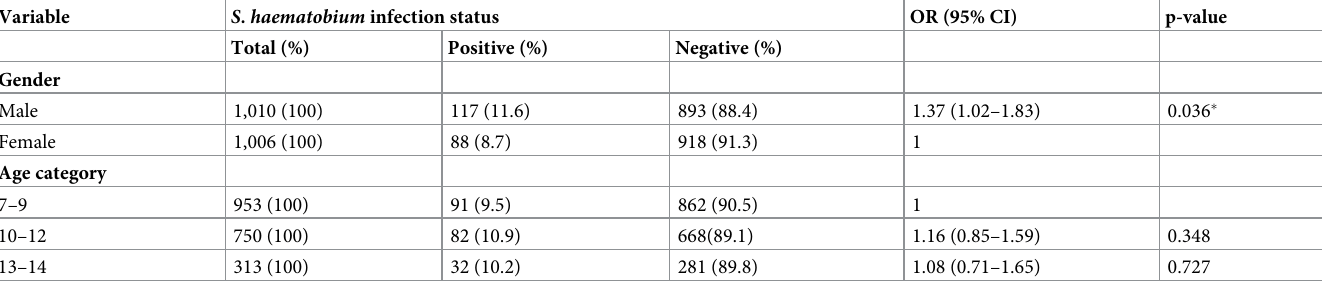
Table 3. Demographic variables as risk factors of urinary schistosomiasis infection among school children in 4 regions of The Gambia, 2015.